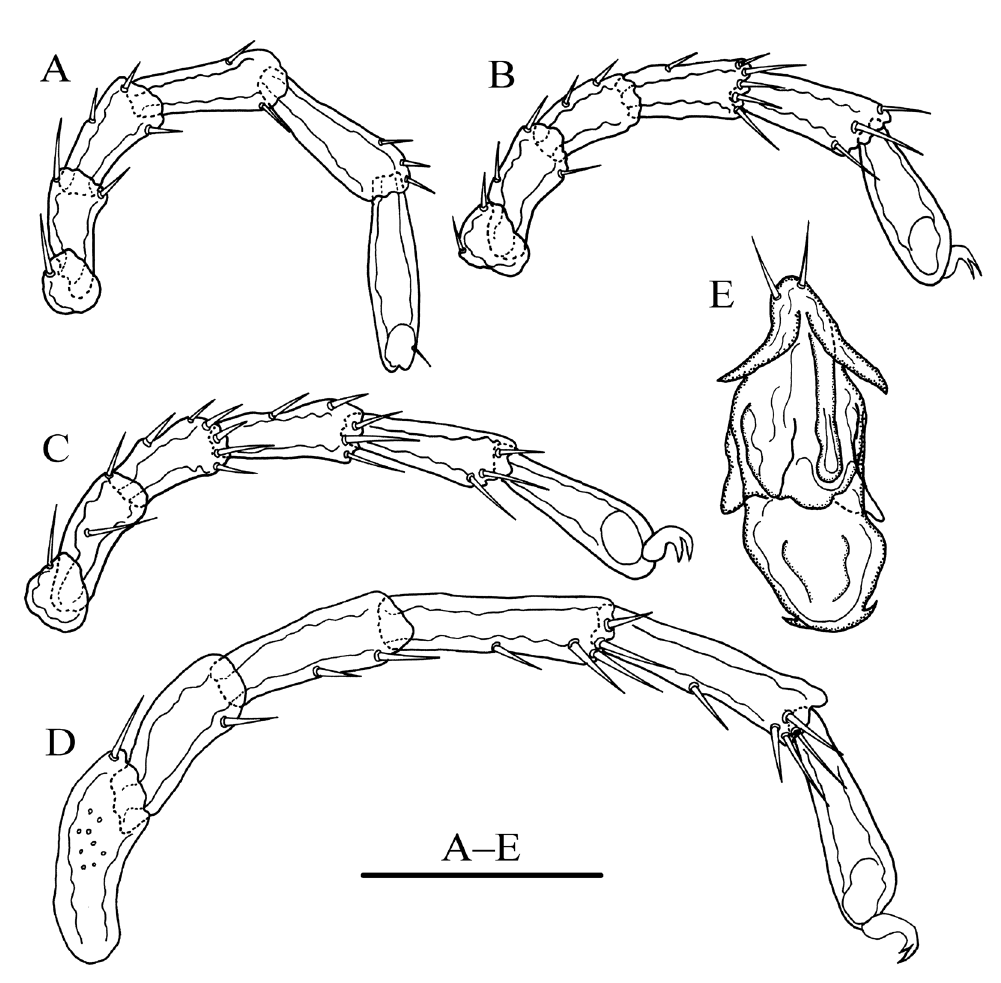
Fig. 14. Torrenticola dentifera Wiles, 1991, ♂ , (FJ-TO-20180806). A . leg-I. B . leg-II. C . leg-III. D . leg- IV. E . Ejaculatory complex. Scale bar = 100